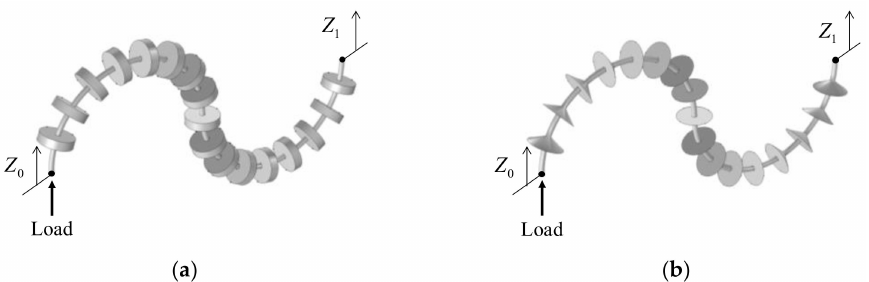
Figure 17. Model of ( a ) the round cylindrical metamaterial and ( b ) the round conical